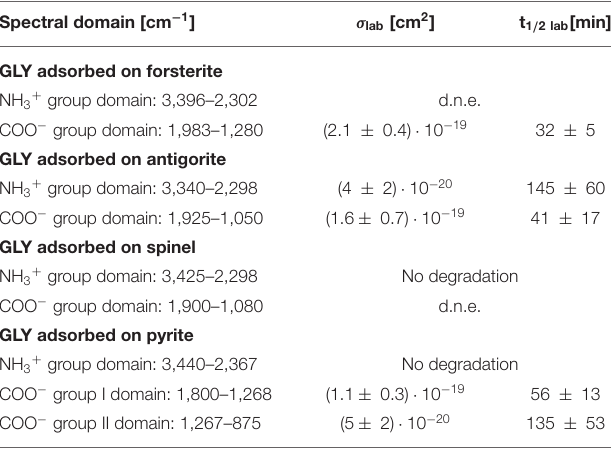
TABLE 8 | Destruction cross sections σ lab and half-life t 1 / 2 lab in laboratory conditions for spectral domains of GLY adsorbed on minerals under UV irradiation. Spectral domain [cm − 1 ] σ lab [cm 2 ] t 1 / 2 lab